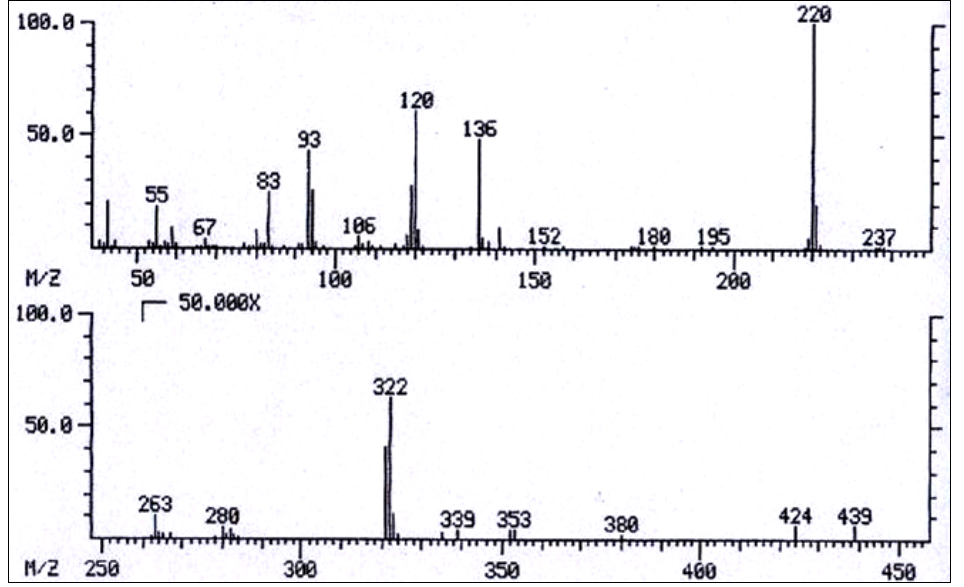
Figure 15. Mass spectrum of